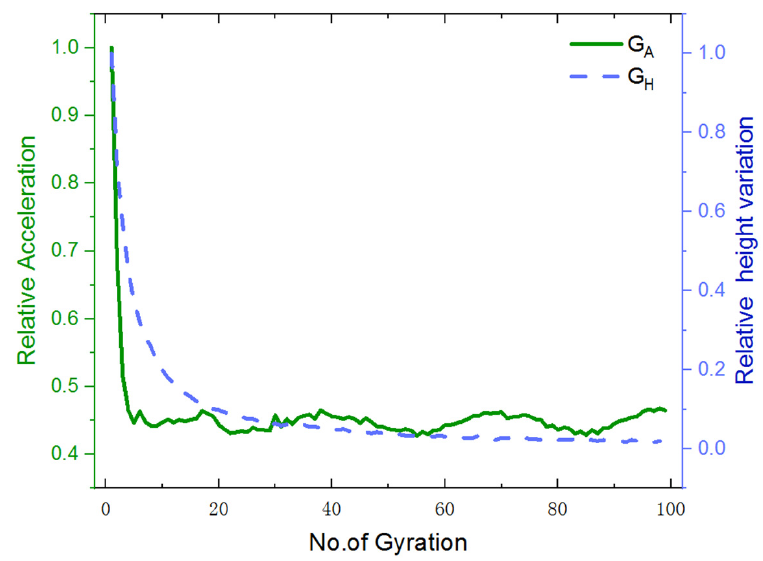
Figure 16. The relative specimen height %H and the relative particle acceleration %A plotted against the number of gyrations. Table 5. The variance statistics of particle accelerations at different positions of gyratory specimens designed by the orthogonal array